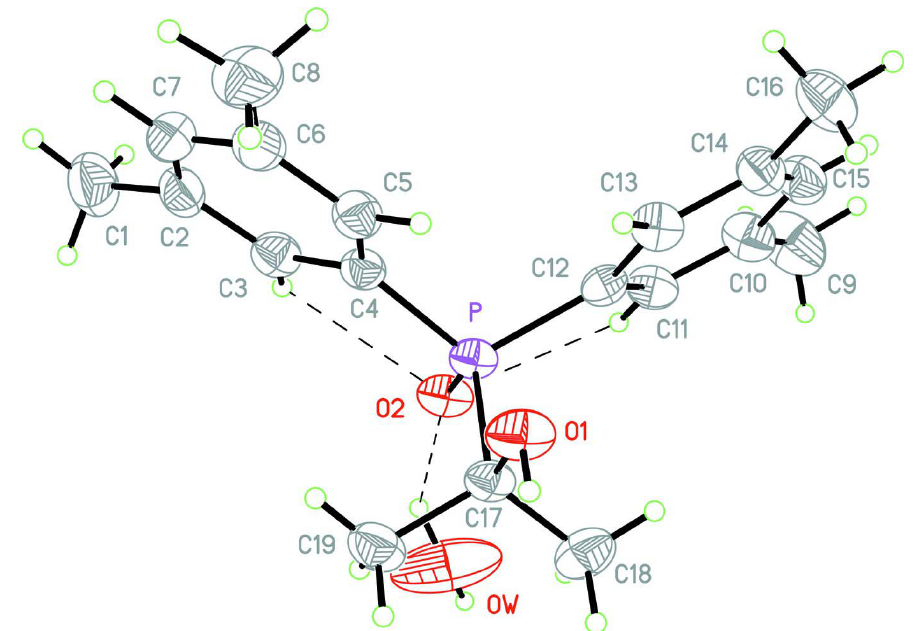
Figure 1 The molecular structure of the title molecule, with the atom-numbering scheme. Displacement ellipsoids are drawn at the 40% probability level. Hydrogen bonds are shown as dashed